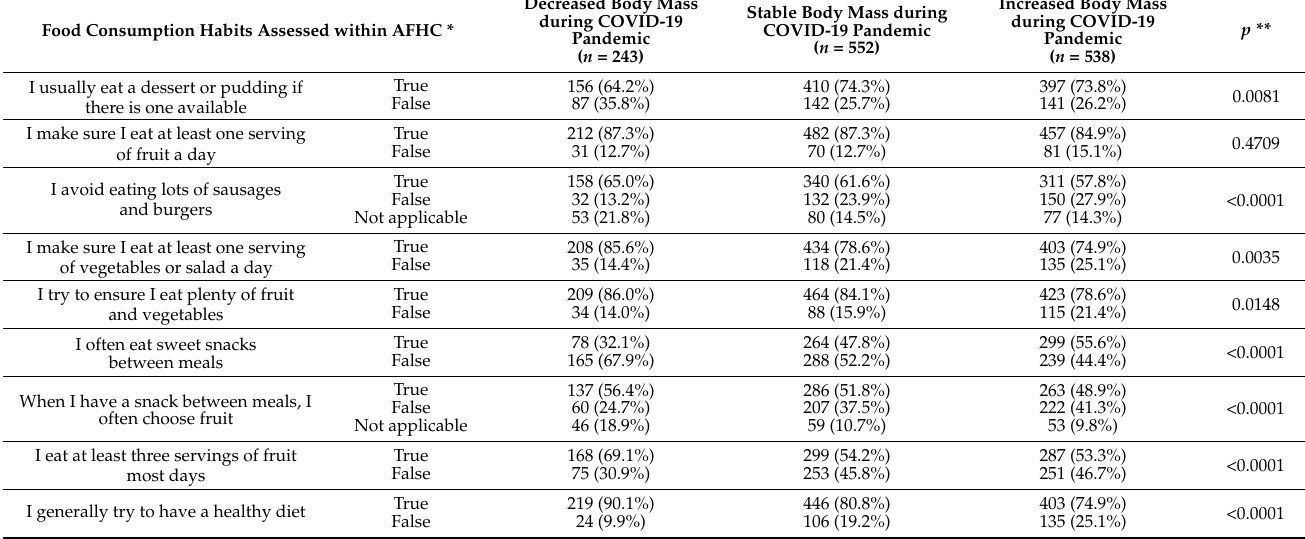
Table 6. The food consumption habits assessed while using Adolescents’ Food Habits Checklist (AFHC) in the period during the COVID-19 pandemic, as declared by the adolescents from the Diet and Activity of Youth during COVID-19 (DAY-19) Study cohort ( n = 1333) in sub-groups of adolescents declaring decreased, stable, and increased body mass during the COVID-19